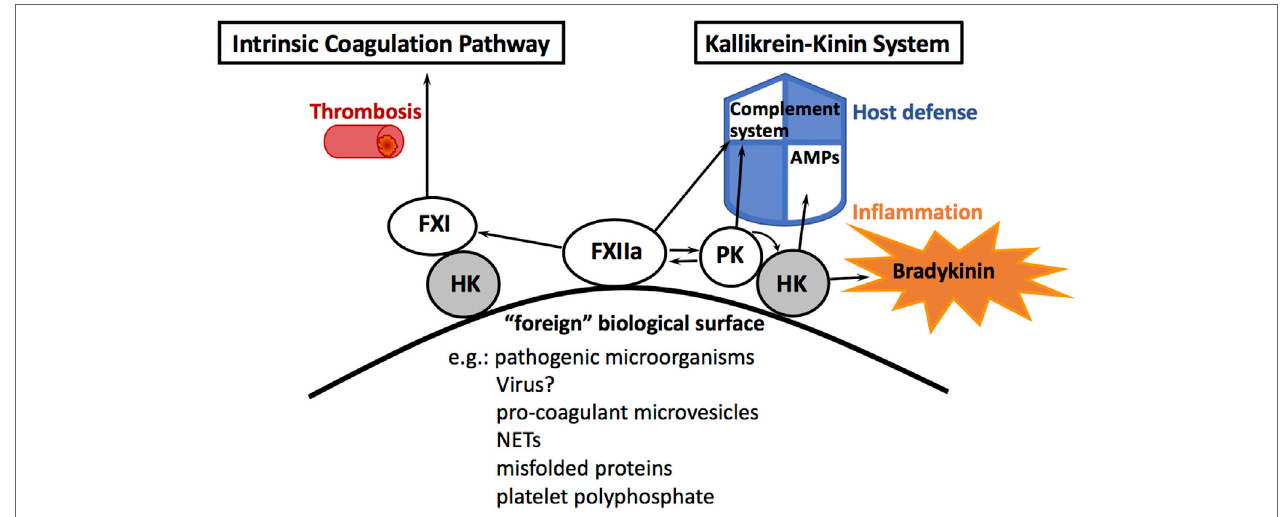
FiGURe 1 | The human contact system. Assembly of contact system factors on foreign biological or artificial surfaces activates factor XII (FXII). FXIIa activates factor XI (FXI) that triggers the intrinsic pathway of coagulation, which is involved in thrombosis. FXII also activates plasma kallikrein (PK), which cleaves high molecular weight kininogen (HK), followed by the release of the pro-inflammatory peptide bradykinin and antimicrobial peptides (AMPs). FXII and PK contribute in vitro to complement